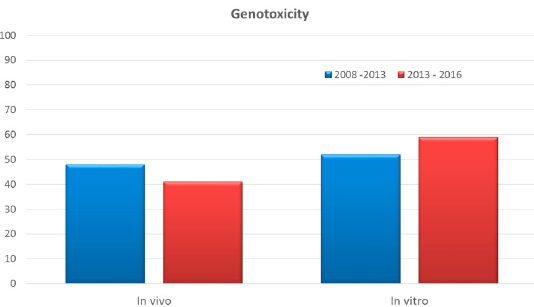
Figure 5. Evolution of the percentage of studies performed in vivo and in vitro to evaluate potential genotoxicity of cosmetic ingredients—number of studies 64 (2008–2013) and 175 (2013–2016).